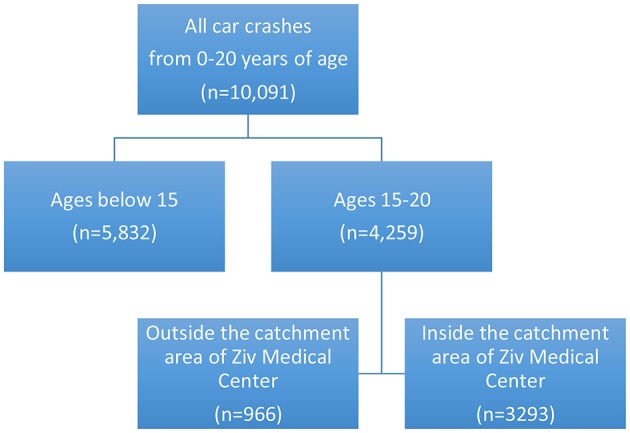
Sample Selection.